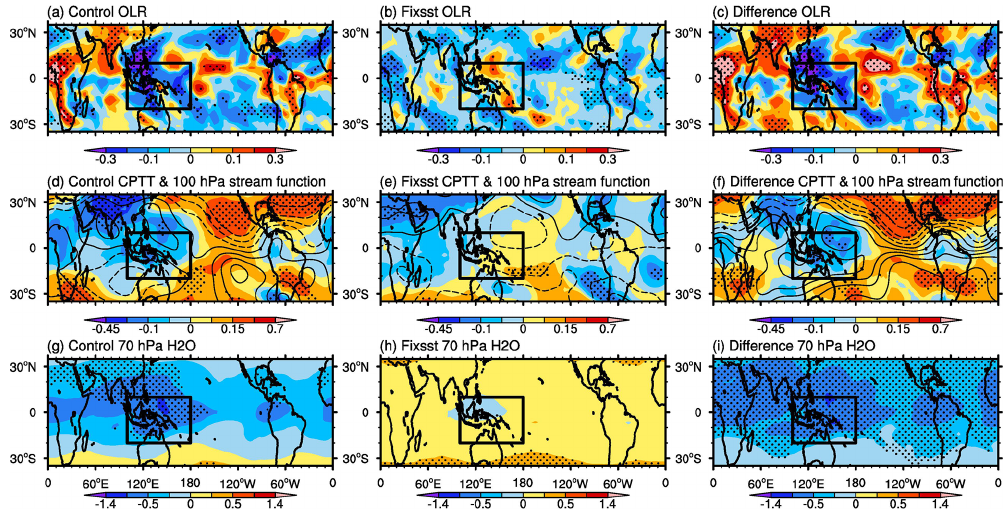
Figure 7. Same as Fig. 5 but for the trends of (a–c) OLR (Wm − 2 a − 1 ), (d–f) CPTT (shading; 10 − 1 Ka − 1 ) and 100hPa stream function (contour; 10 6 m 2 s − 1 a − 1 ), and (g–i) 70hPa water vapour concentration (10 − 2 ppmva − 1 , where ppmv is parts per million by volume). The trends in panels (a) – (c) and (g) – (i) over the dotted regions are statistically significant at the 95% confidence level. The CPTT trends in panels (d) – (f) over the dotted regions are statistically significant at the 95% confidence level. The black rectangles denote the TWP region (20 ◦ S–10 ◦ N, 100–180 ◦ E).